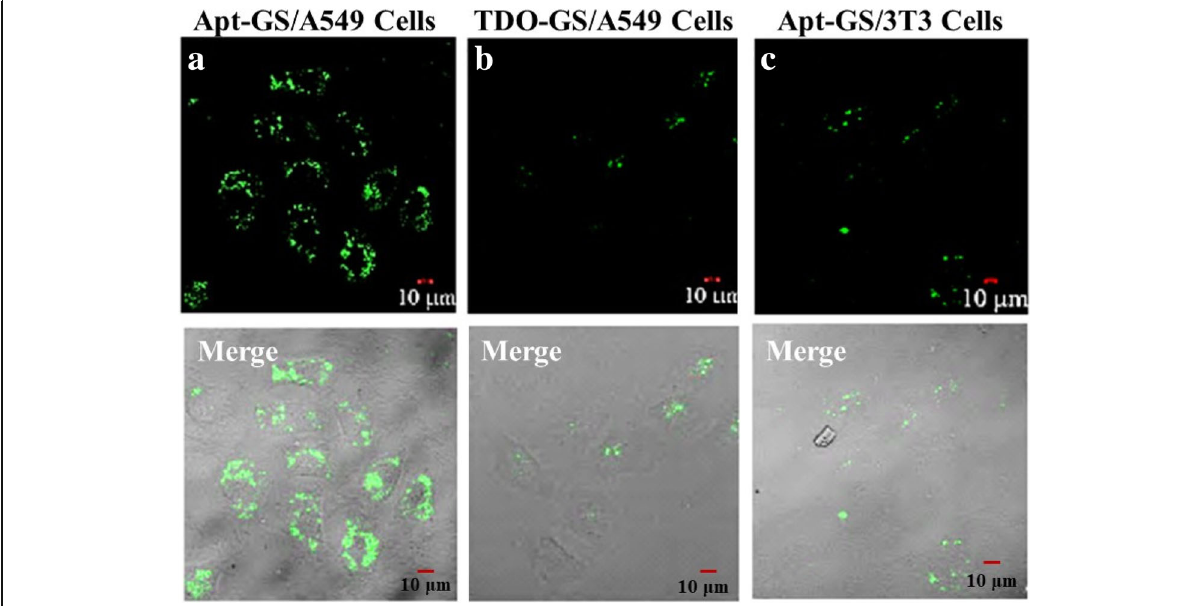
Fig. 5 a – c Cell uptake of FAM-siRNA delivered by Apt-GS and TDO-GS nanogels. Images were taken with CLSM. Green signal: FAM. Scale